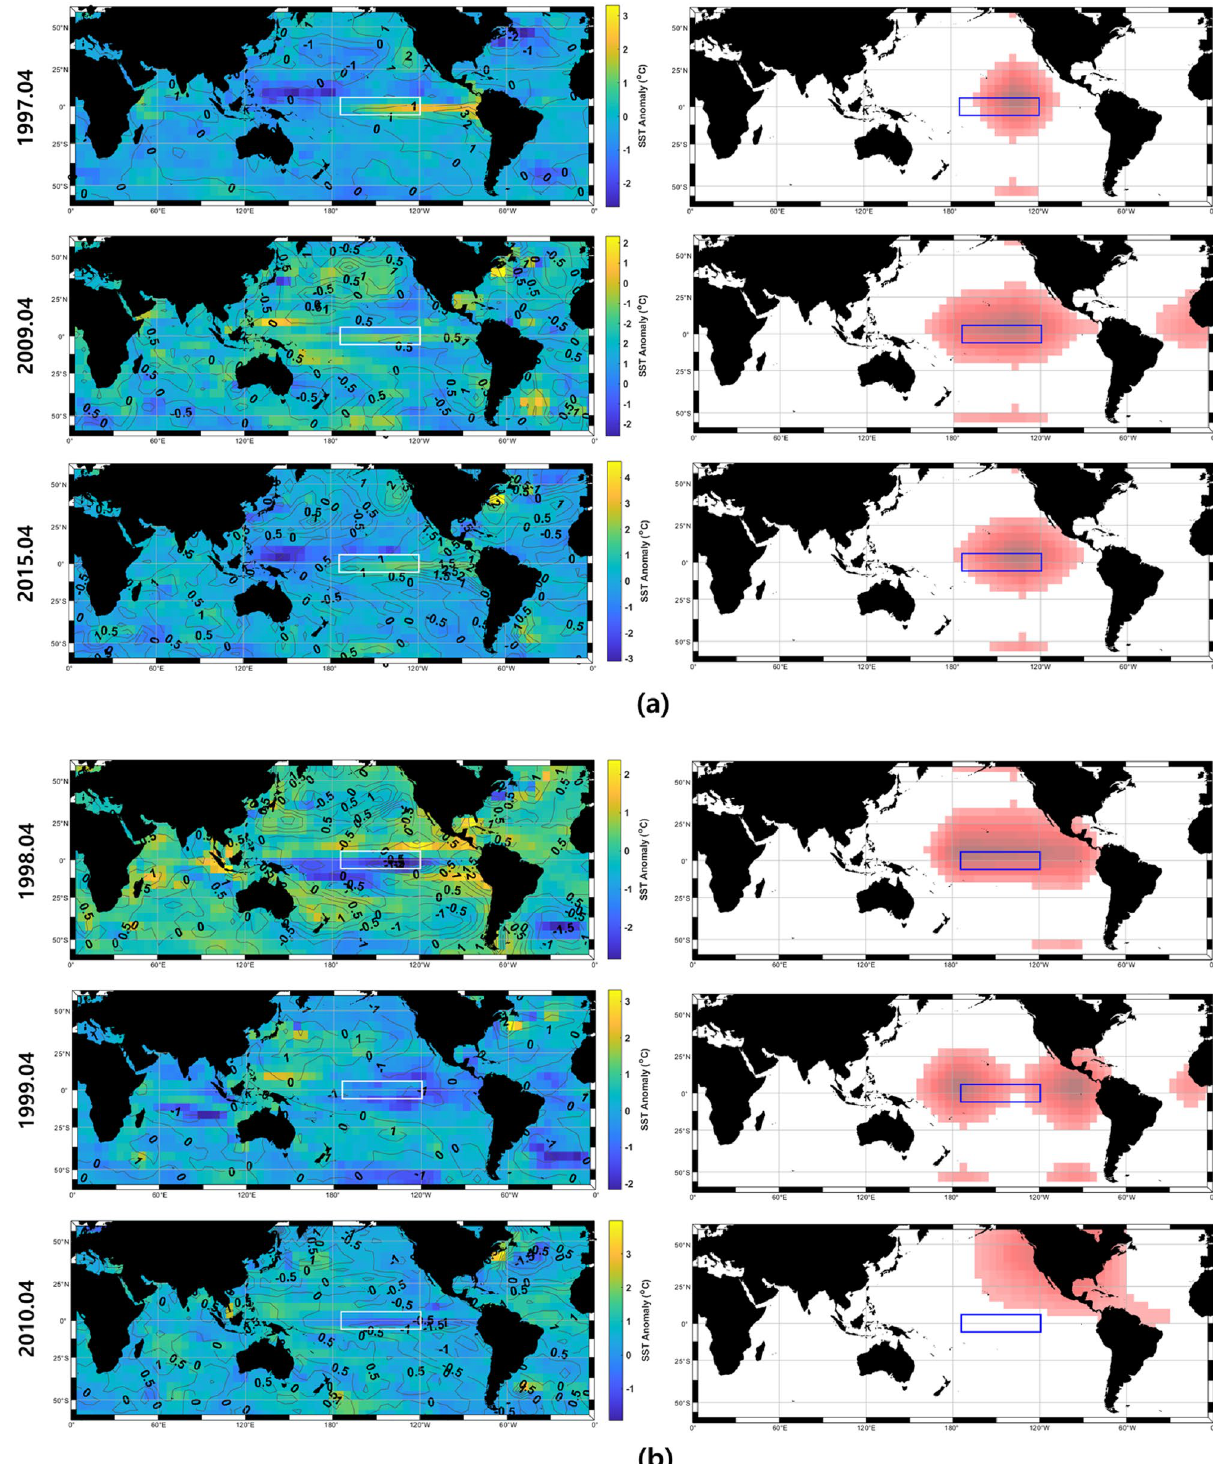
Figure 6. Visualization of trained attention maps that acted as precursors to representative ( a ) three El Niño events of 1997/1998, 2009/2010, and 2015/2016 (top to bottom) and ( b ) three La Niña events of 1998/1999, 1999/2000, and 2010/2011 (top to bottom). Shaded backgrounds and contours are spatial distributions for SST and HC anomalies several months prior to the event occurrence (see each figure title at the far left of the picture) used as inputs for El Niño and La Niña predictions in the left column of the figure. And the red gradient area in the right column of the figure shows the region where the proposed STANet is most affected by the input data given for Nino3.4 prediction. And the white and blue boxes show the region of Nino3.4. This figure is generated using Matlab R2018b (https:// kr. mathw orks. com/ produ cts/ matlab.